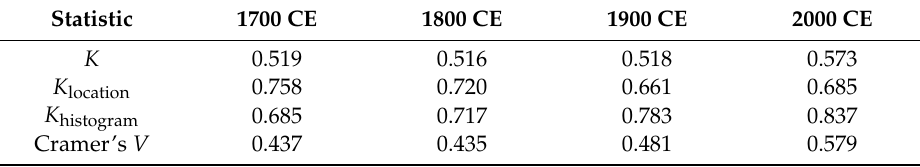
Table 2. Statistical indicators of agreement between Anthromes 12K and Anthromes 2.0 maps. Statistic 1700 CE 1800 CE 1900 CE 2000 CE K 0.519 0.516 0.518 0.573 K location 0.758 0.720 0.661 0.685 K histogram 0.685 0.717 0.783 0.837 Cramer’s V 0.437 0.435 0.481